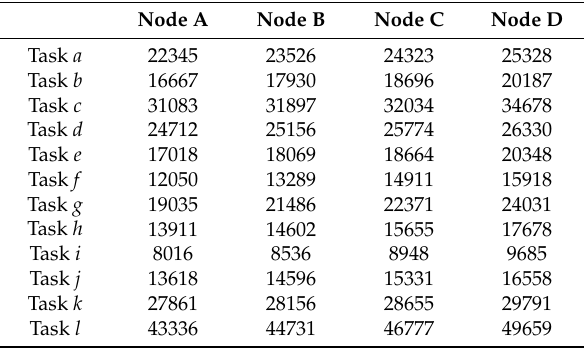
Table 4. Illustration of the expected execution times of tasks.